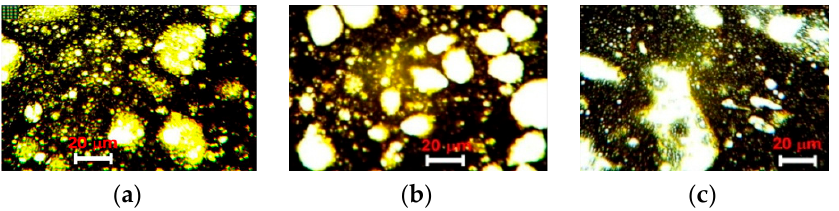
Figure 4. Microphotographs of W/OE (10×) at temperatures: ( a ) 22 °C (1.9 µm); ( b ) 32 °C (3.6 µm); and ( с ) 40 °C (4.7 µm).